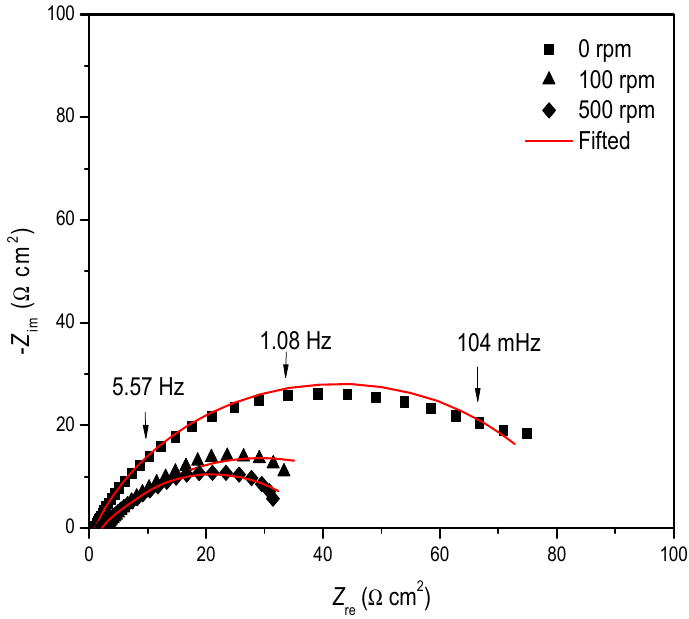
Figure 4. Nyquist diagram of 1018 steel immersed in 3% of NaCl + CO 2 at different rotation rates. Figure 5 shows the Nyquist diagrams at different rotation rates and